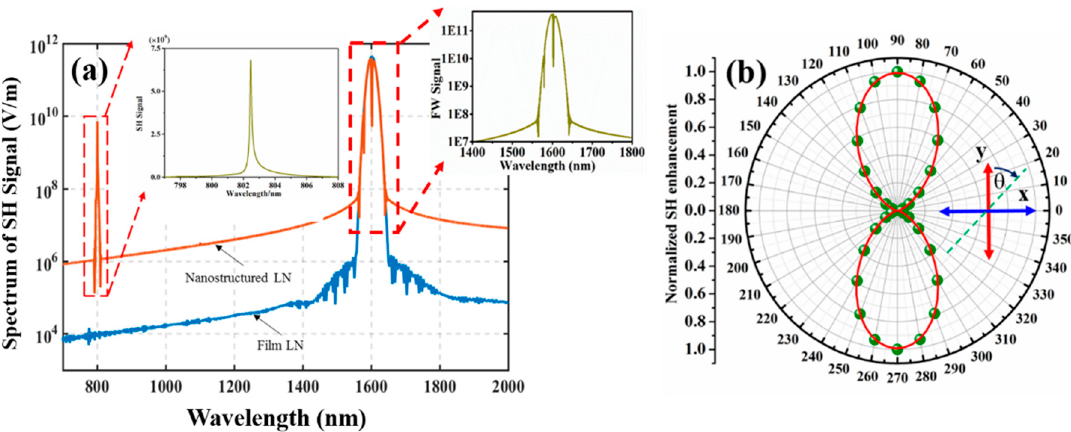
Figure 4. ( a ) The simulated SH signal with the optimized structure parameters. The orange curve is obtained for the nanostructured LN while the blue curve is obtained for the unstructured TFLN. The inset shows a magnified view of the SHG spectrum which peaks at 802 nm. ( b ) Polar diagram of the SH signal (normalized to the maximum) for the nanostructured LN, under different incident polarization angles. The polarization angle θ is defined as shown in the inset.